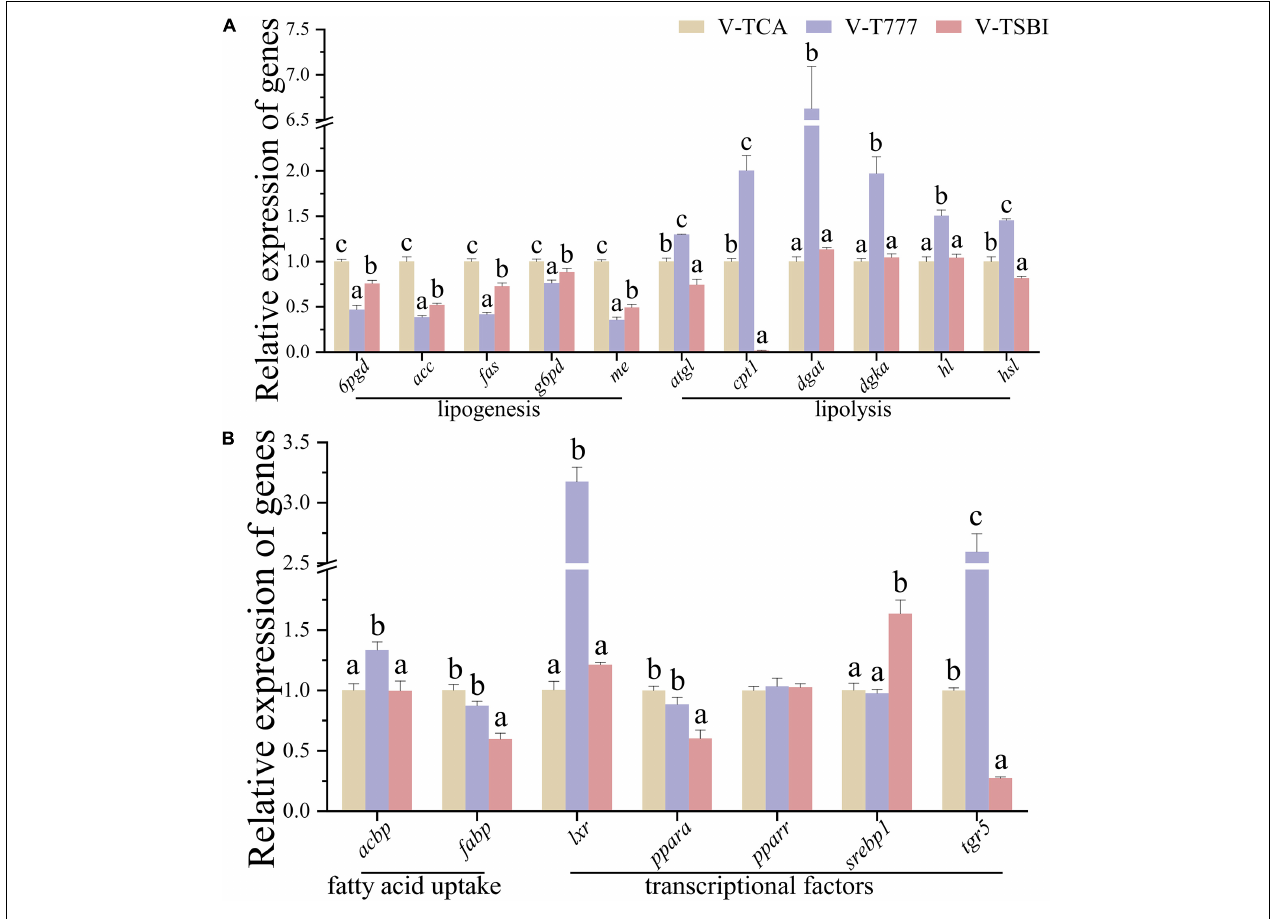
FIGURE 8 | The relative expression of genes associated with lipid metabolism of hepatocytes normalized to 18s and β -actin in TGR5 agonist or antagonist incubation (A,B) ( n = 9). Values are presented as means with SD , where significant ( p < 0.05) differences between groups are indicated by different